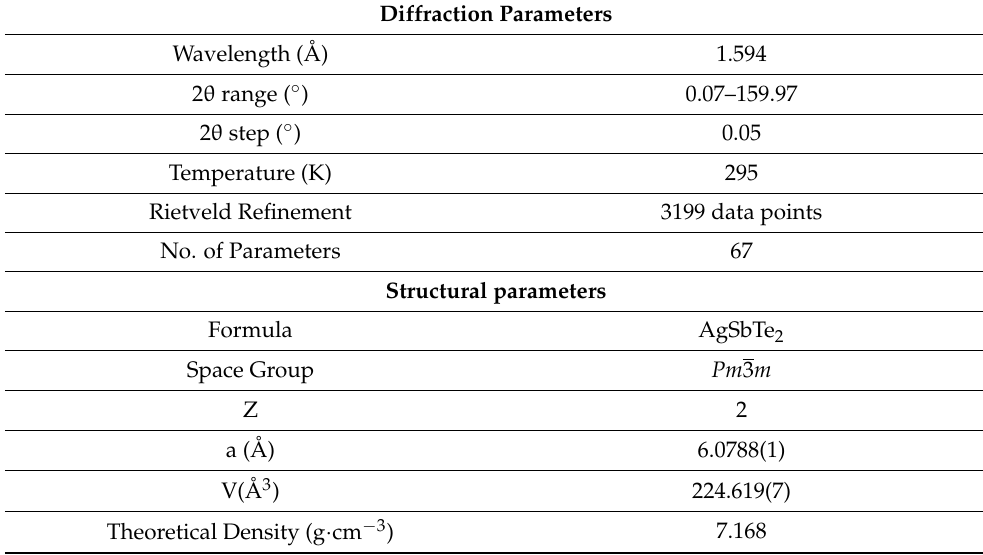
Table 1. NPD experimental parameters of AgSbTe 2 at room temperature.